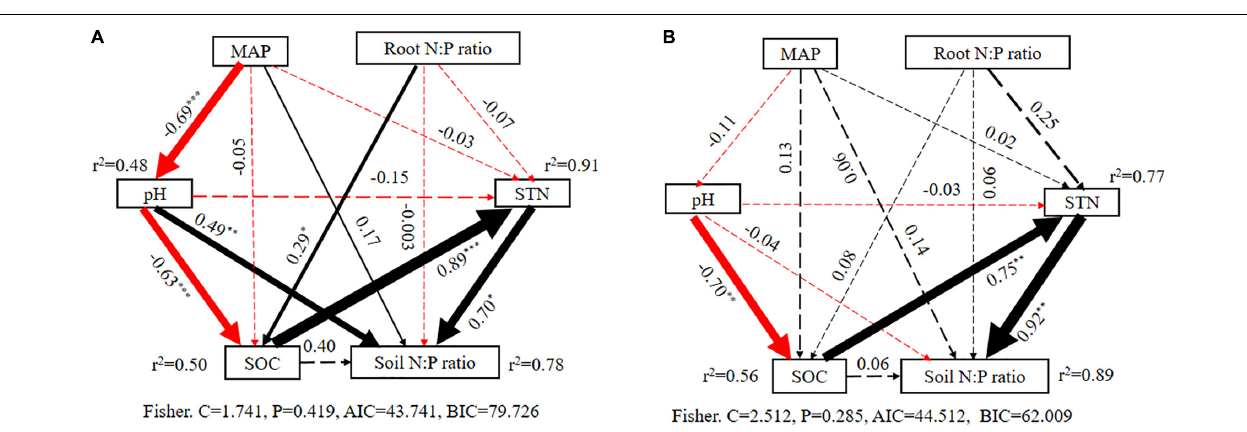
FIGURE 9 | Structural equation models illustrating the effects from direct and indirect factors on soil nitrogen (N):phosphorus (P) ratio in alpine shrublands (A) and desert shrublands (B) . The width and values of the arrow indicate the relative effect size and standardized path coefficients. The dashed arrows show pathways of non-significant effects ( P > 0.05). MAP: mean annual precipitation, SOC: soil organic carbon, STN, soil total nitrogen. “*”, “**”, and “***” indicate significant differences at the levels of P < 0.05, P < 0.01, and P <